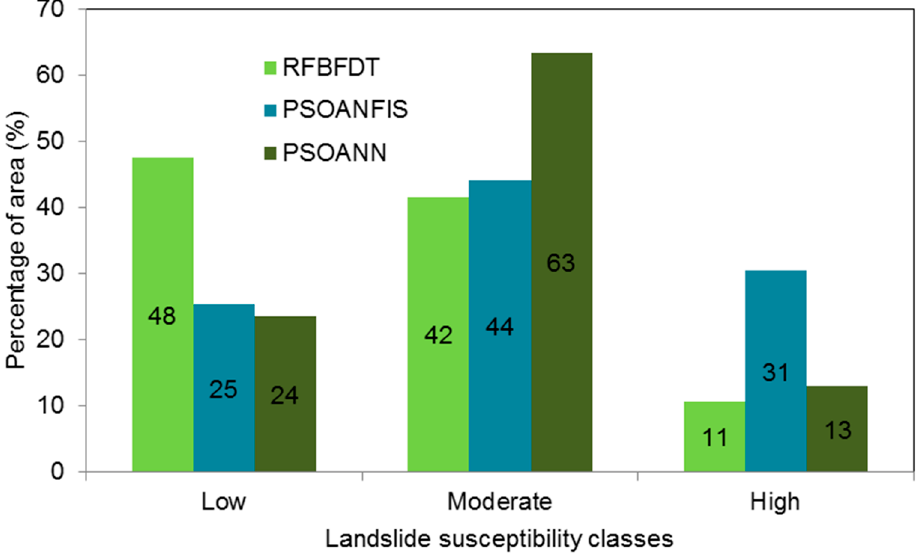
Figure 12. Distribution of classes on the susceptibility maps.